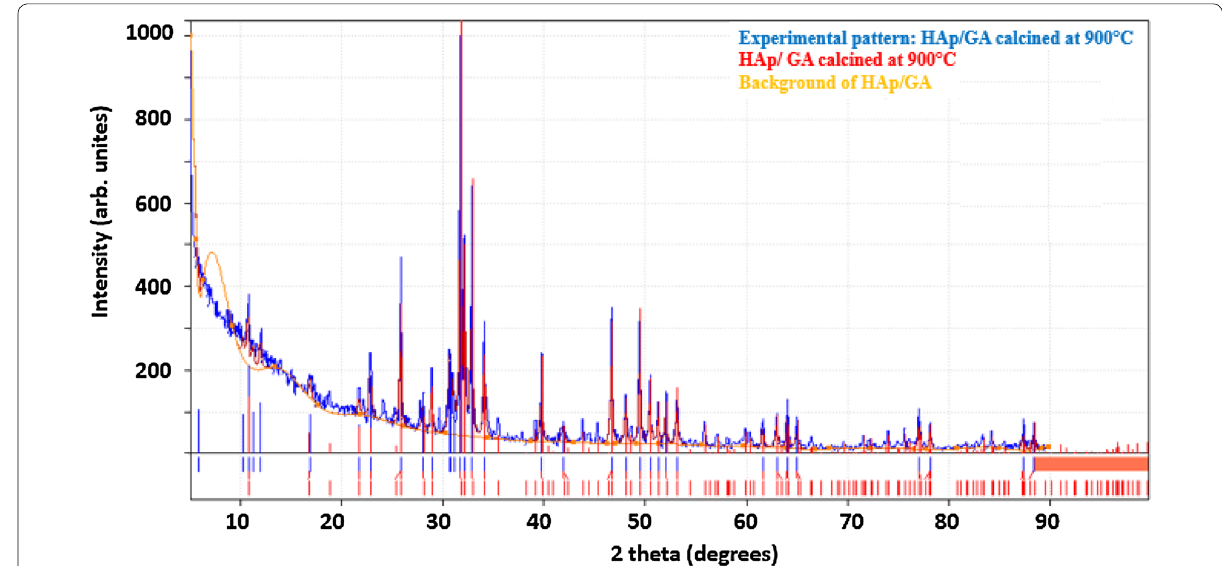
Fig. 3 XDR patterns of HAp/GA composite calined at 900